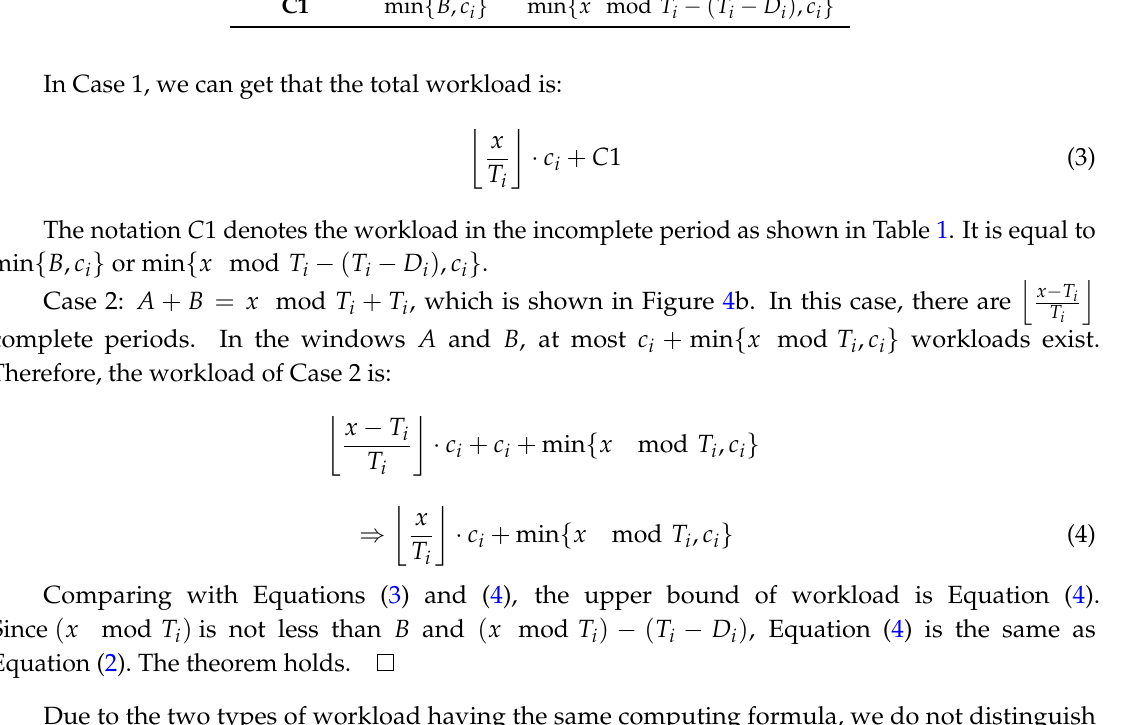
. ( a ) A + B = x mod T i ; ( b ) A + B = x mod T i + T i . k